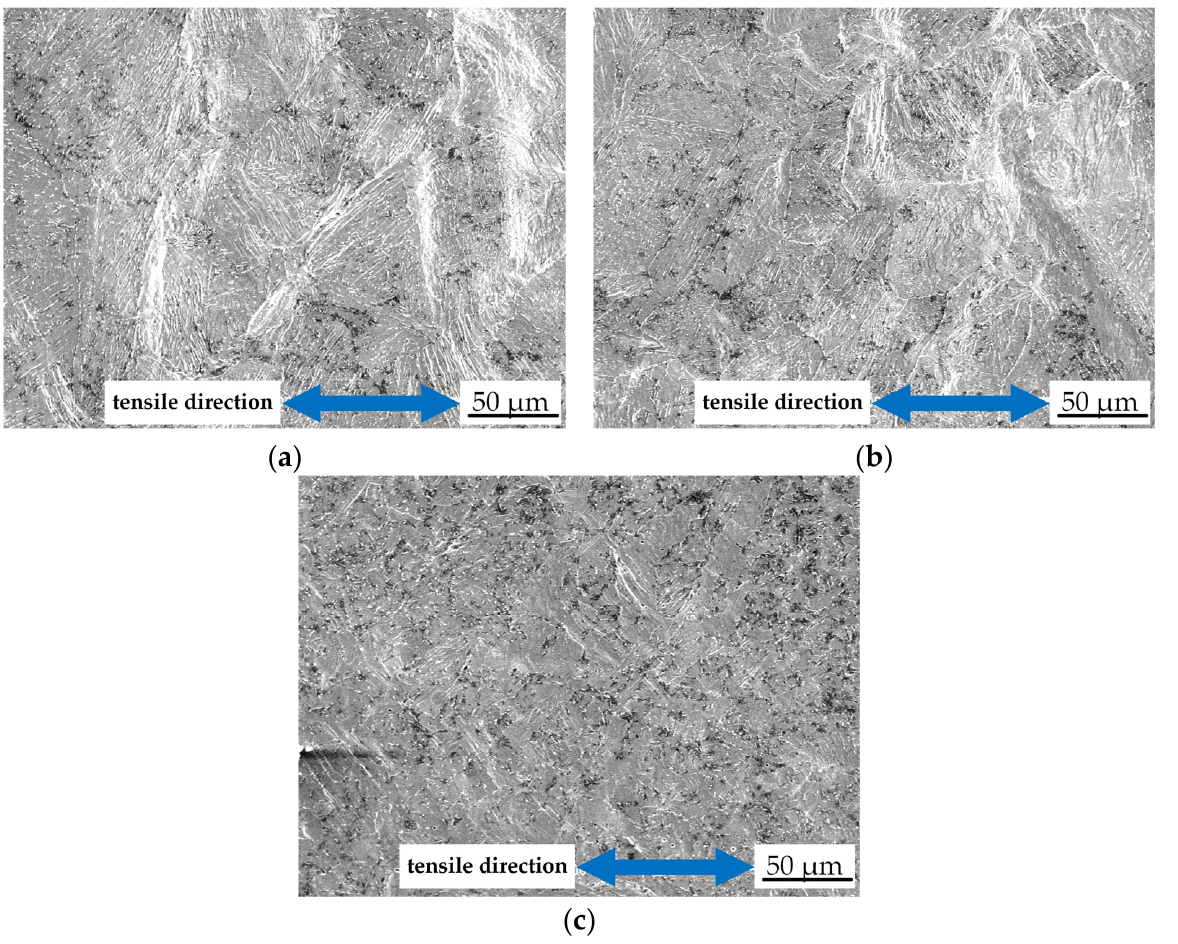
Figure 7. Deformation characteristics of observation points with different thicknesses in the WM: ( a ) after first stretching at point F; ( b ) after first tension at point C; ( c ) after first tension at point G.